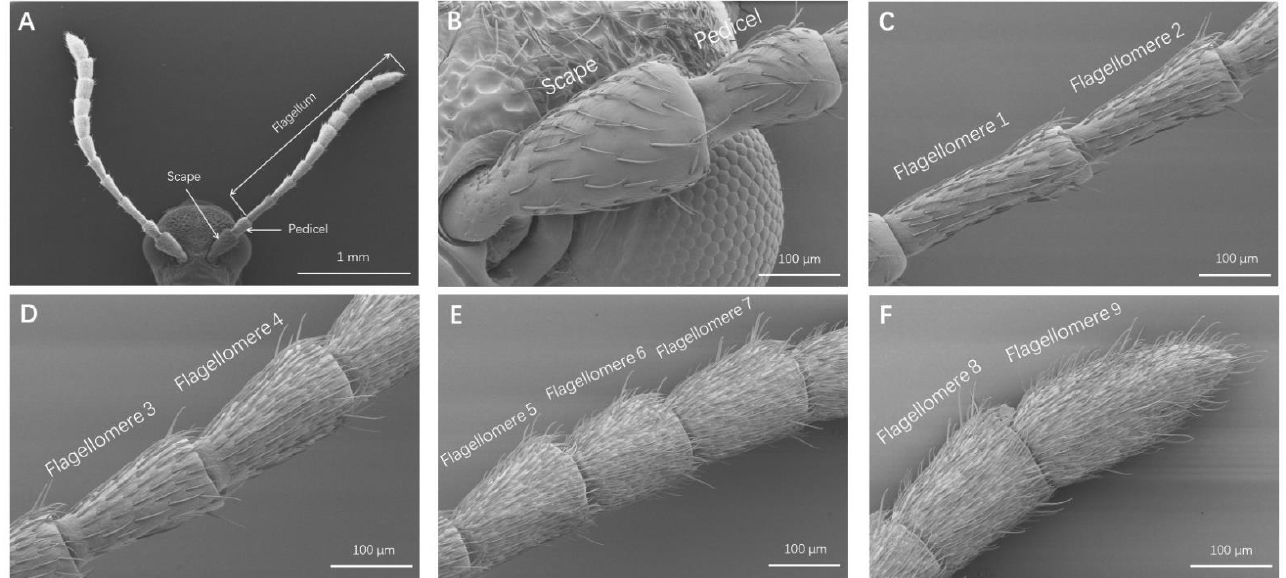
Figure 1. Ophraella communa antennae. ( A ) Overview of the female antenna showing the scape, pedicel, and flagellomeres. ( B ) Scape and pedicel. ( C ) Flagellomere 1, 2. ( D ) Flagellomere 3, 4. ( E ) Flagellomere 5 – 7. ( F ) Flagellomere 8, 9.